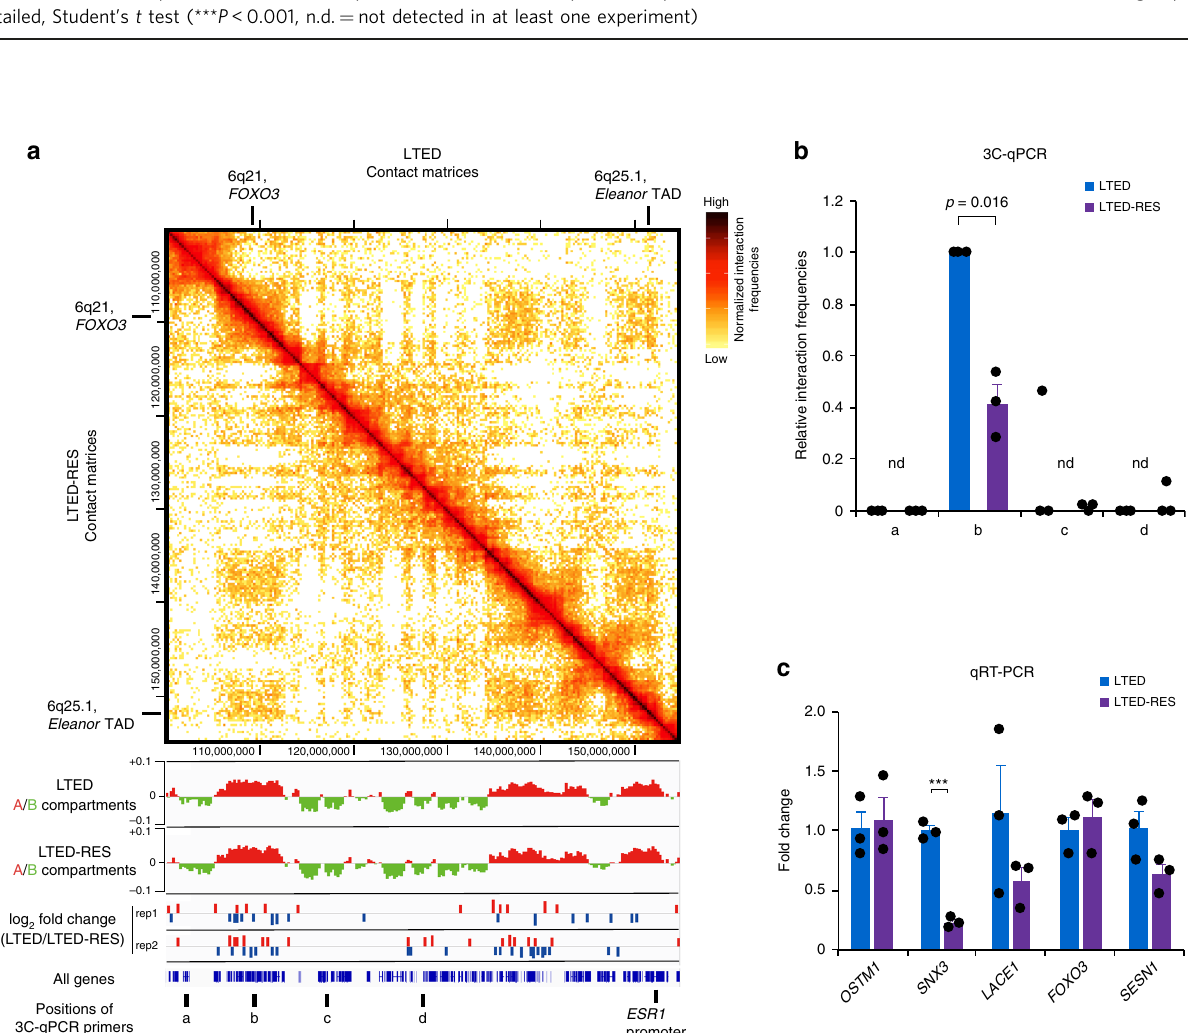
Fig. 3 Resveratrol treatment reduced the interaction between ESR1 and FOXO3 but maintained the FOXO3 gene activity. a The resveratrol treatment affected the interaction between the Eleanor topologically associating domain and other A compartments. Top: Contact matrices from Hi-C, binned at 250- kb resolution. The normalized interaction frequencies of long-term estrogen deprivation (LTED) and LTED-RES cells are shown above and below the diagonal line, respectively. Middle: A/B compartments and fold changes in the contact frequencies. Positions of gained (red) and reduced (blue) contacts with the ESR1 promoter are shown. Bottom: Positions of all genes and 3C-qPCR (chromosome conformation capture – quantitative polymerase chain reaction) primers, as in Fig. 2a. b 3C-qPCR shows the relative interaction frequencies of the b site decreased by resveratrol treatment. c Relative expression levels of genes at 6q21 in LTED and LTED-RES cells. The LTED expression level was set to 1. Data presented in b , c are representative of three independent experiments (mean ± s.e.m.). P values were calculated using unpaired, two-tailed, Student ’ s t test (*** P < 0.001, n.d. = not detected in at least one